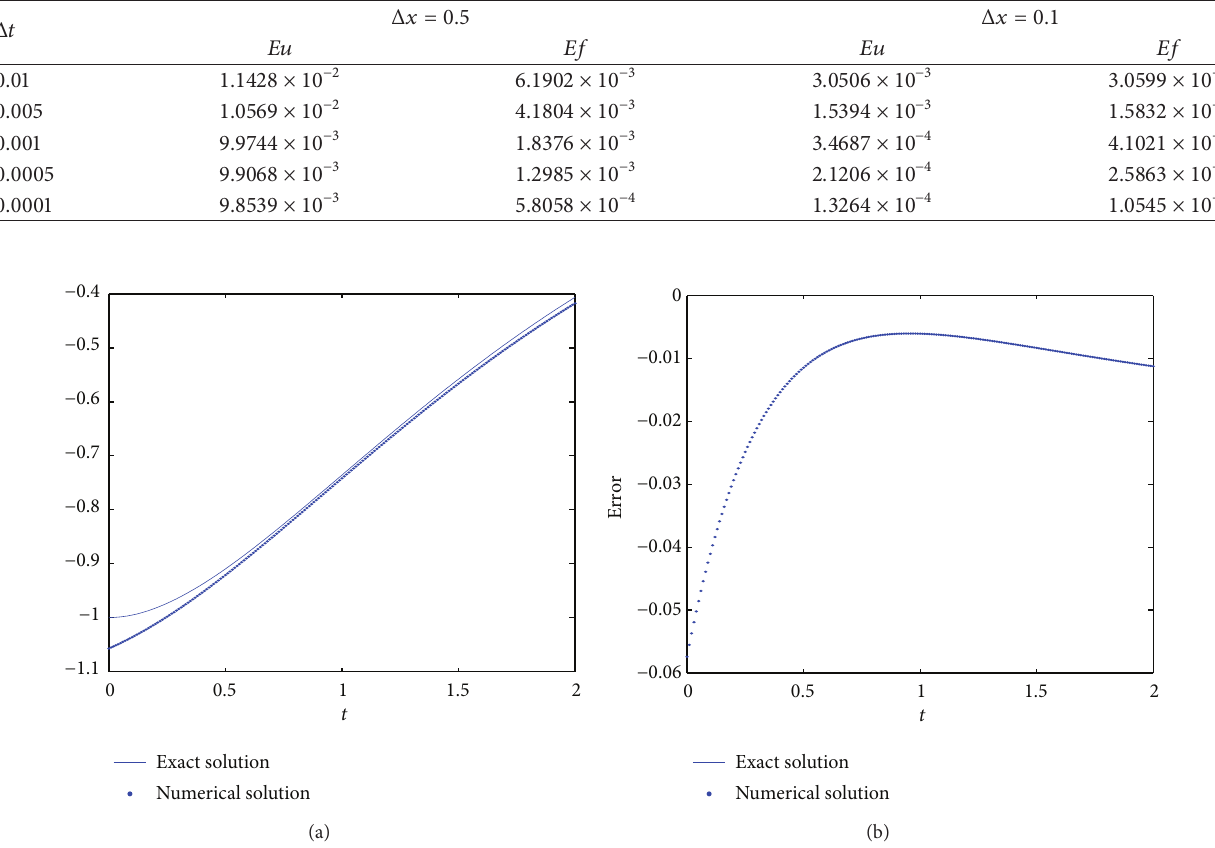
̂𝑓(𝑡) ̂𝑓(𝑡) (a), the error 𝑓(𝑡) − (b) with Δ𝑥 = 0.5 , Δ𝑡 = 0.01 .